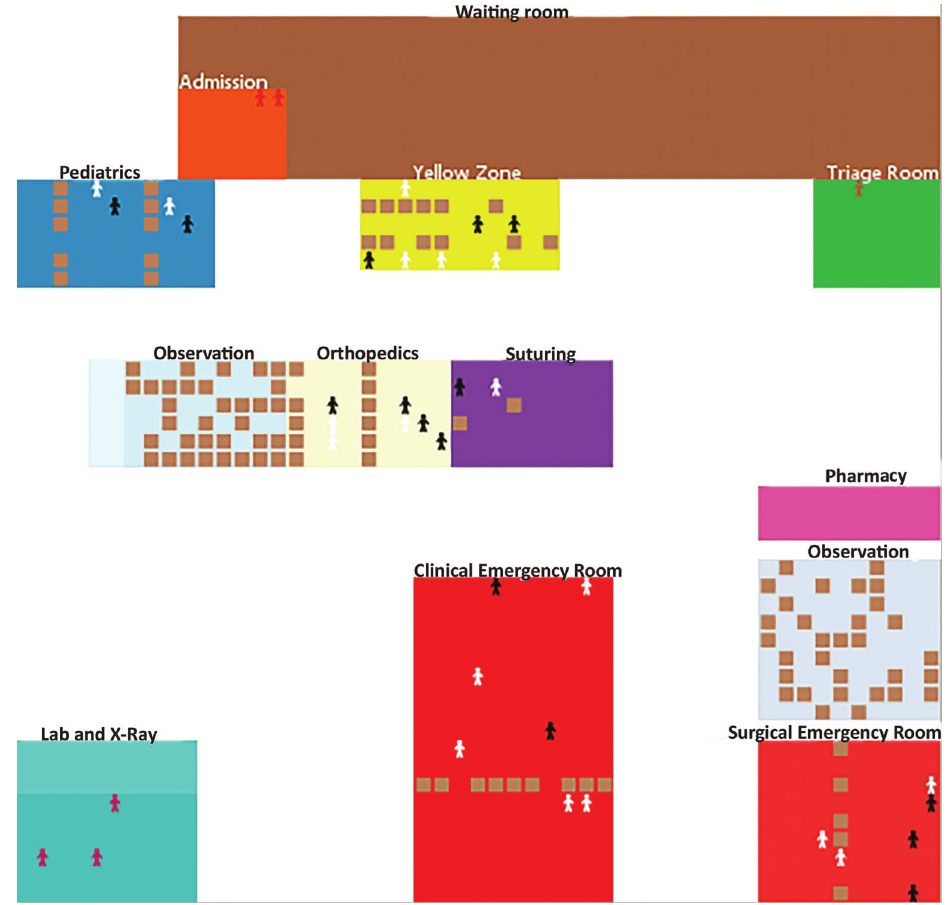
Figure 4. Environment of an agent-based simulation system of an emergency room produced by NetLogo. Each section of an emergency department is represented by a distinct color and each small square represents a bed. Doctors and nurse technicians are shown in black and white, respectively.